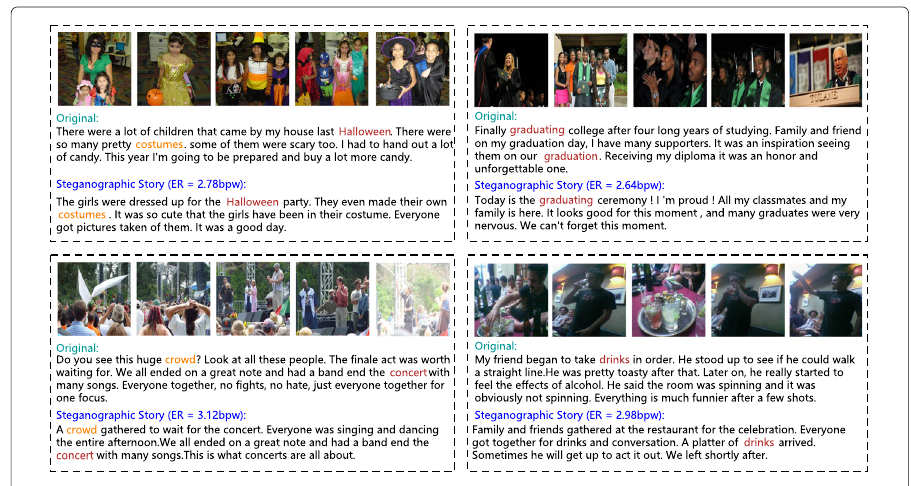
Fig. 4 Some examples of steganographic visual stories generated from five photos with adaptive information hiding